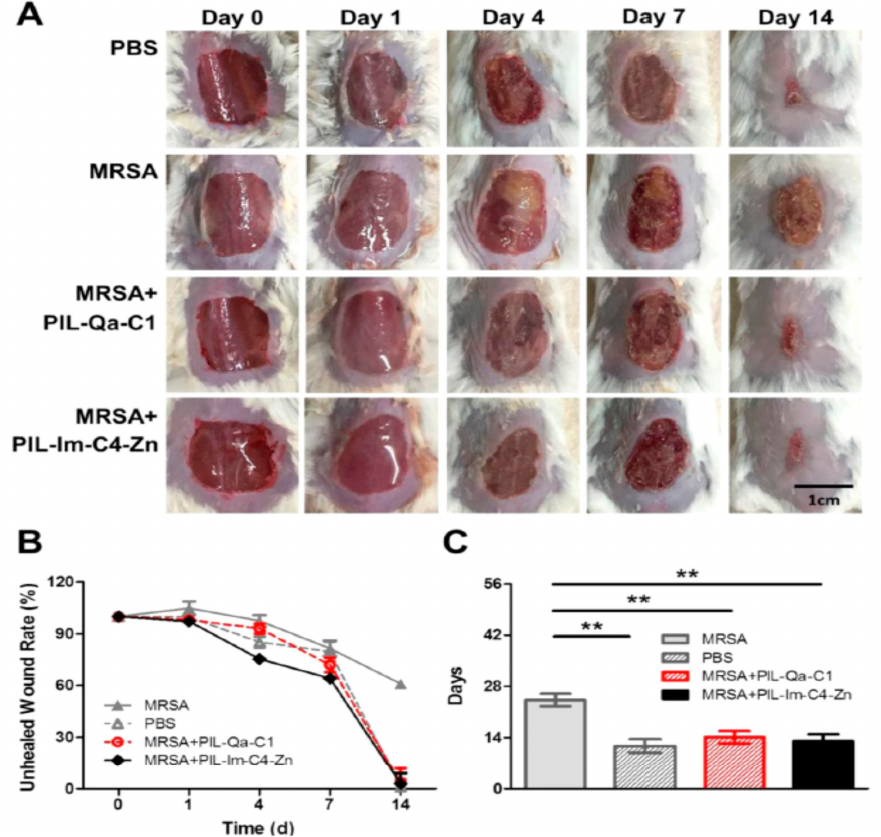
Figure 17. Wound healing evaluation of mouse model. Representative images ( A ) and unhealed wound rates ( B ) of skin wounds in 4 groups during 14 postoperative days. ( C ) Days for complete wound healing in four groups. Data are presented as mean ± SD, n = 6 in PBS negative control group and n = 11 in the other 3 groups; ** represents p < 0.01. Adapted from [189].